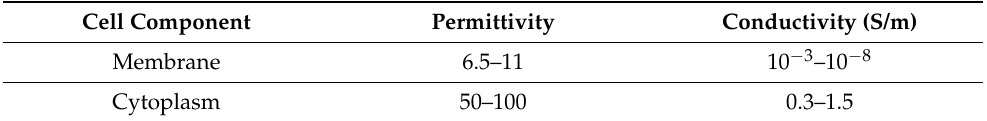
Table 3. Initial estimates of dielectric parameters used prior to non-linear regression for obtaining the best-fit parameters by minimizing the residual error; values for the membrane are obtained from [18], and cytoplasmic conductivity range is modified to 0.30–3.0 based on prior studies